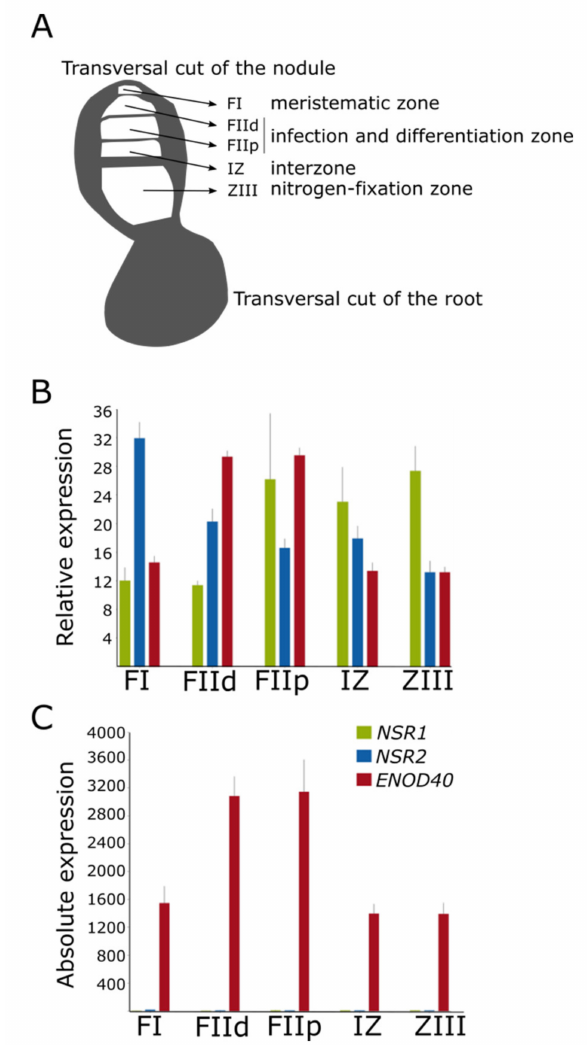
Figure 3. Expression pattern of NSR genes and the lncRNA ENOD40 in each zone of the Medicago truncatula mature nodule, based on [16]. ( A ) Schematic representation of a transversal cut of a M. truncatula root and mature nodule, indicating the zones isolated by laser micro-dissection. Fraction I (FI) corresponds to the nodule meristematic zone; the zones below FI correspond to samples collected as a distal and a proximal Fraction (FIId and FIIp, respectively) and corresponding to cells undergoing di ff erentiation or infection; the Interzone (IZ) separates the fractions above from the nitrogen-fixation zone ZIII. ( B ) Relative transcript levels of NSR1, NSR2, and ENOD40 in each zone of the mature nodule. ( C ) Absolute levels of the same genes shown in B